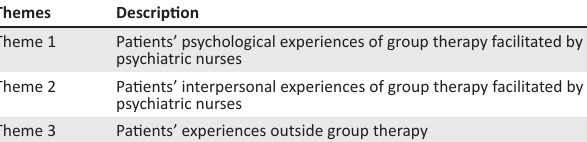
TABLE 2: Patients with mood disorders lived experiences of group therapy by psychiatric nurses.